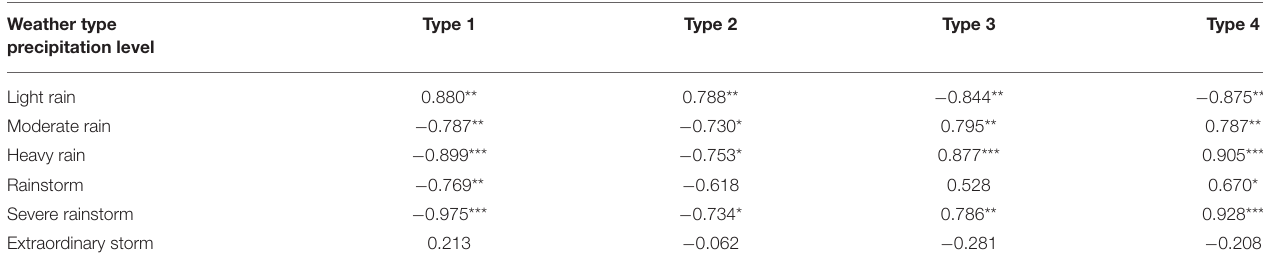
TABLE 2 | Correlation coefficients between weather type frequency and precipitation class frequency,